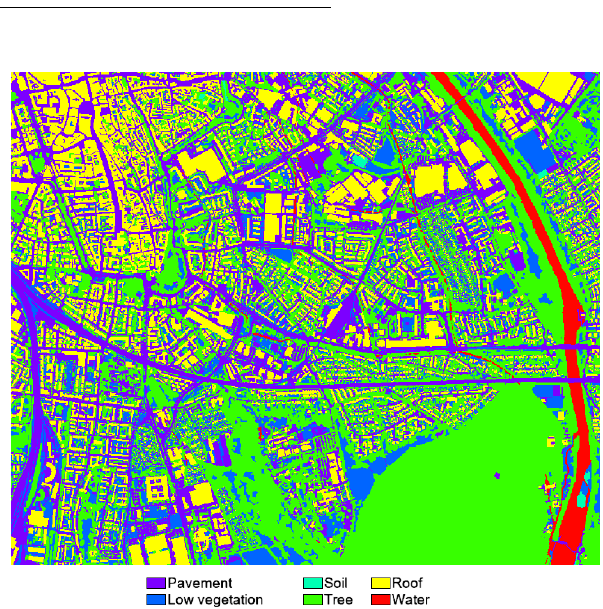
Figure 5. The manually delineated land cover composition of the sub1 region based on the DLR 3K image.